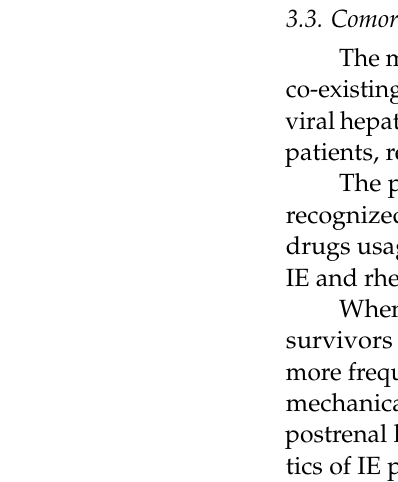
Table note: CoNS—coagulase-negative staphylococci; TOE—transoesophageal echocardiography; EF—ejection fraction of left ventricle, EDD—end-diastolic diameter, ESD—end-systolic diameter, IVS—interventricular septum, TAPSE—tricuspid annular plane systolic excursion, LAVI—left atrial volume index, RVSP—right ventricular systolic pressure. p -Values <0.05 highlighted in